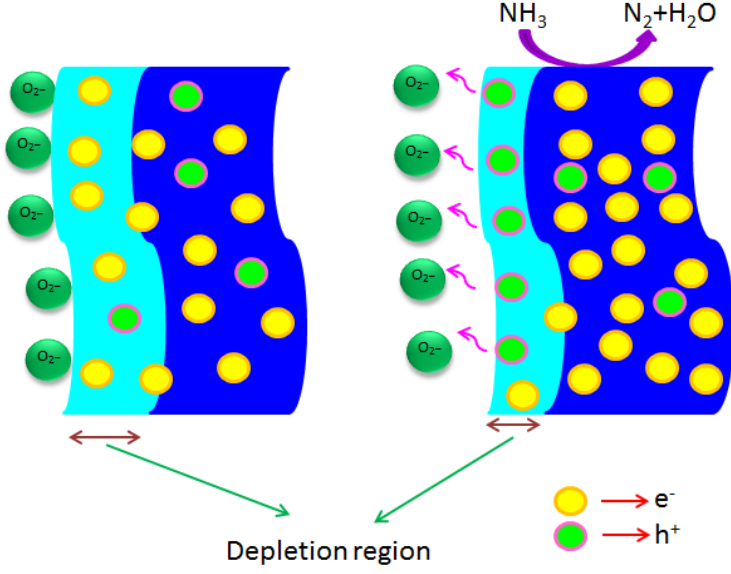
Figure 9. Schematic diagram of MoO 3 gas sensing mechanism.